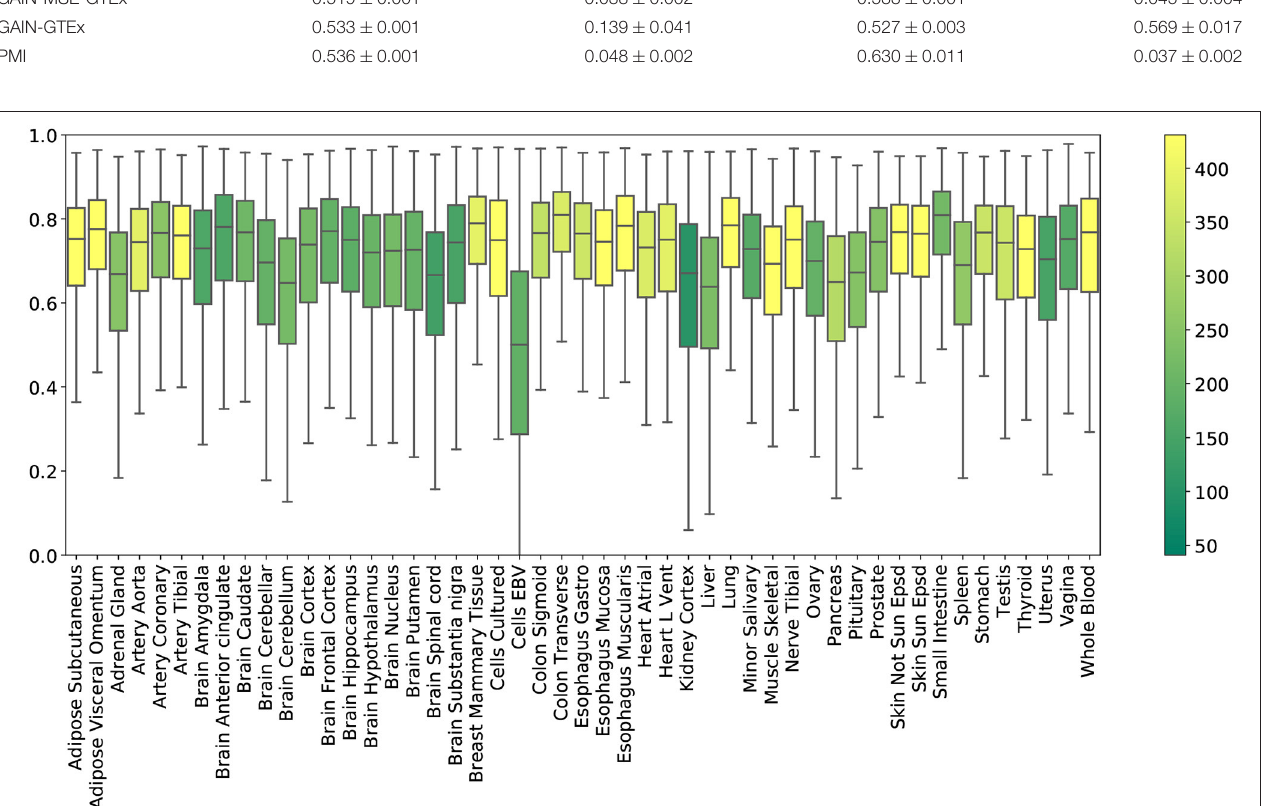
FIGURE 2 | R 2 imputation scores per GTEx tissue with a missing rate of 50% (PMI; inductive mode). Each box shows the distribution of the per-gene R 2 scores in the extended test set. The color of each box represents the number of training samples of the corresponding